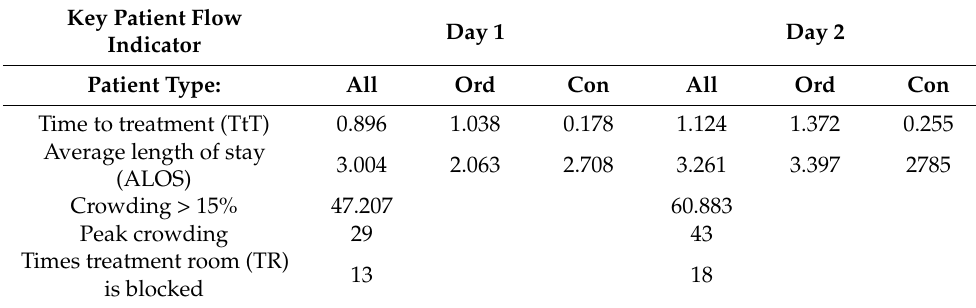
Table 7. Table displaying a subset selection of KPI from Sc.2. Key Patient Flow Indicator